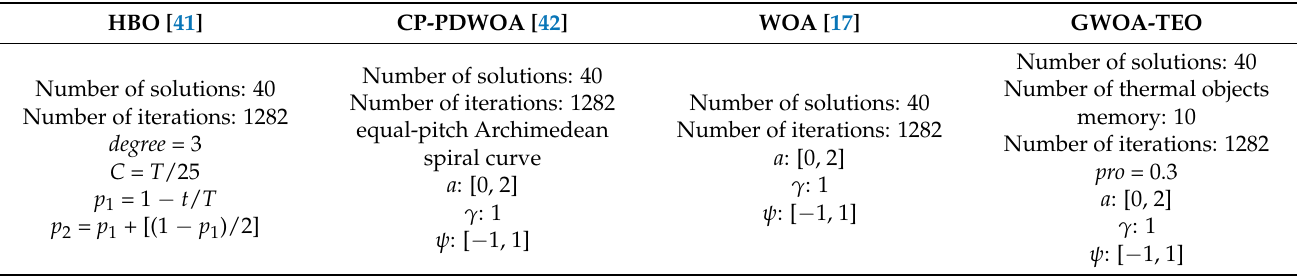
Table 2. Parameter setting of the algorithms for case study